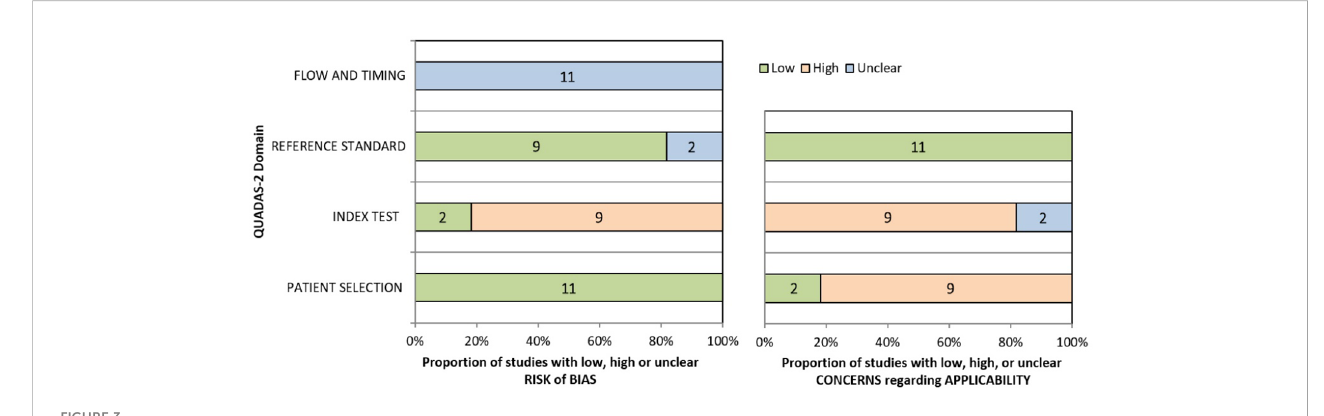
FIGURE 3 The quality assessment of 11 included studies by QUADAS-2 tool.